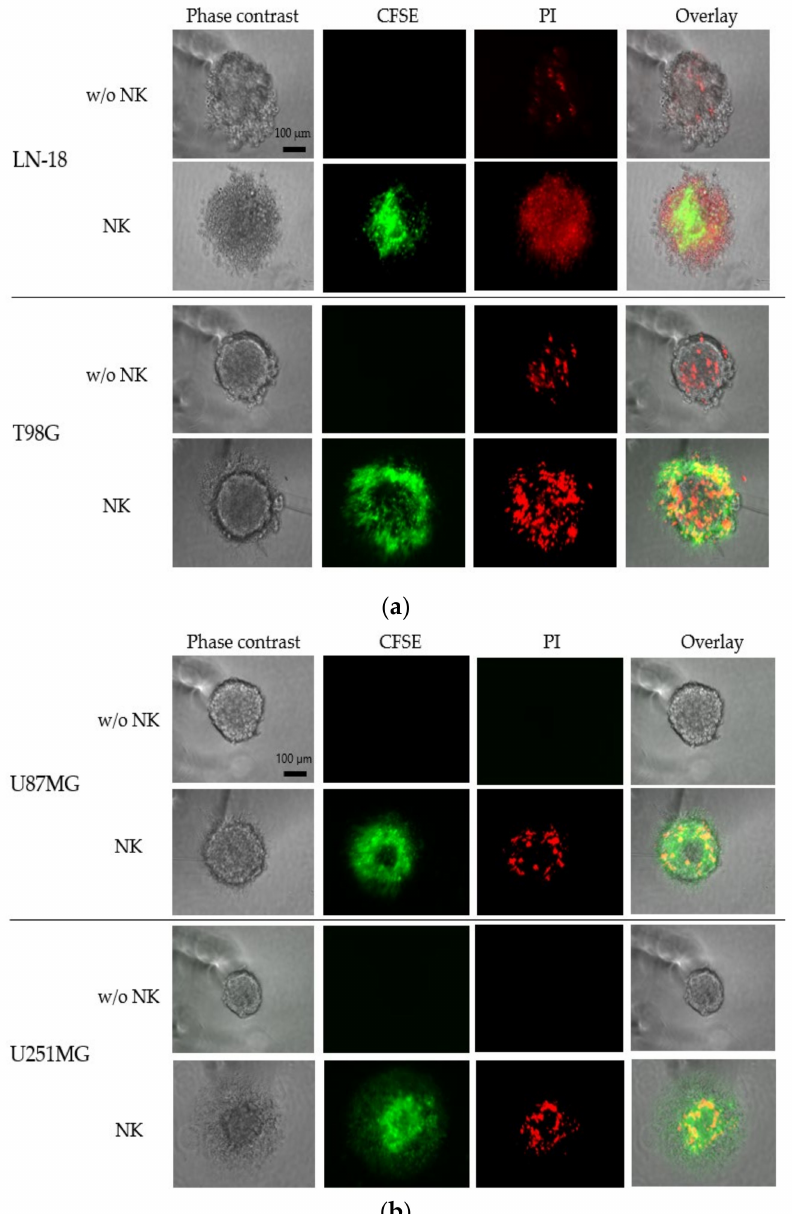
Figure 6. Fluorescent microscopy evaluation of cytotoxicity of the expanded human NK cells against GBM cell-derived spheroids (GBM-sp). The spheroids were co-cultured with carboxyfluorescein diacetate succinimidyl ester (CFSE)-labeled NK cells (green) for 24 h. After incubation, propidium iodide (PI, red) was added to the spheroids and incubated for 15 min. Left panels depict the phase-contrast images of the spheroids derived from LN-18, T98G ( a ), U87MG, and U251MG cells ( b ); scale bar = 100 µ m; the second and third row panels depict the fluorescent microscopic images for detecting CFSE and PI. The images on the right depict the overlay view of the CFSE and PI fluorescent microscopic images under phase-contrast